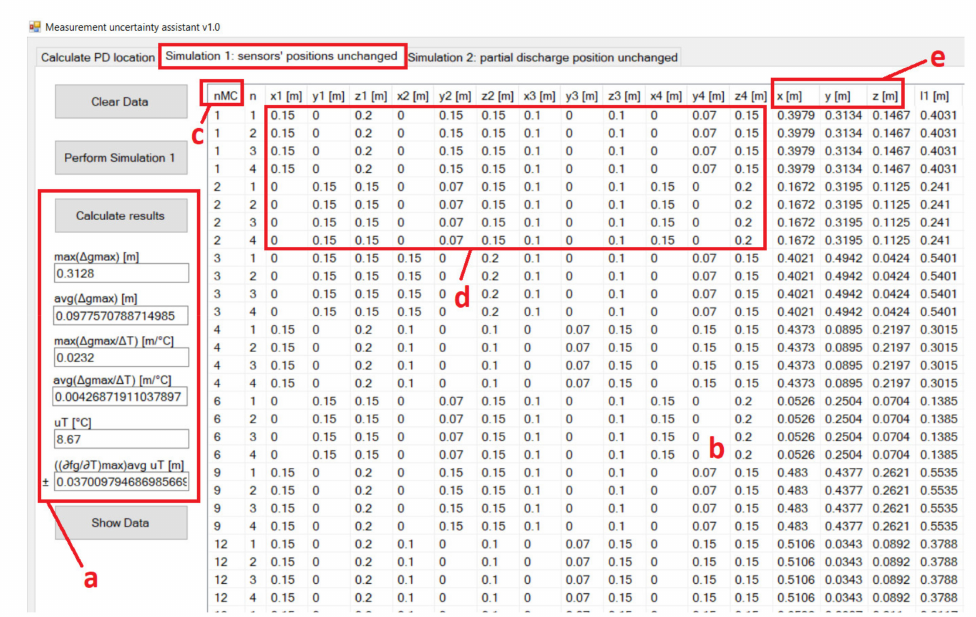
Figure 3. Presentation of the results of the first variant of the algorithm for simultaneous variations in input variables in the MUA software. ( a ) Calculation and display of significant simulation parameters; ( b ) display of valid simulation results and selected columns from the database; ( c ) MC simulation number; ( d ) the sensors’ arrangement is different depending on the PD position; ( e ) random positions of PD.